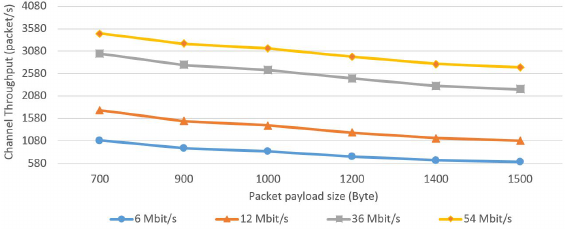
Figure 9: Channel throughput for externals in Scenario 2.